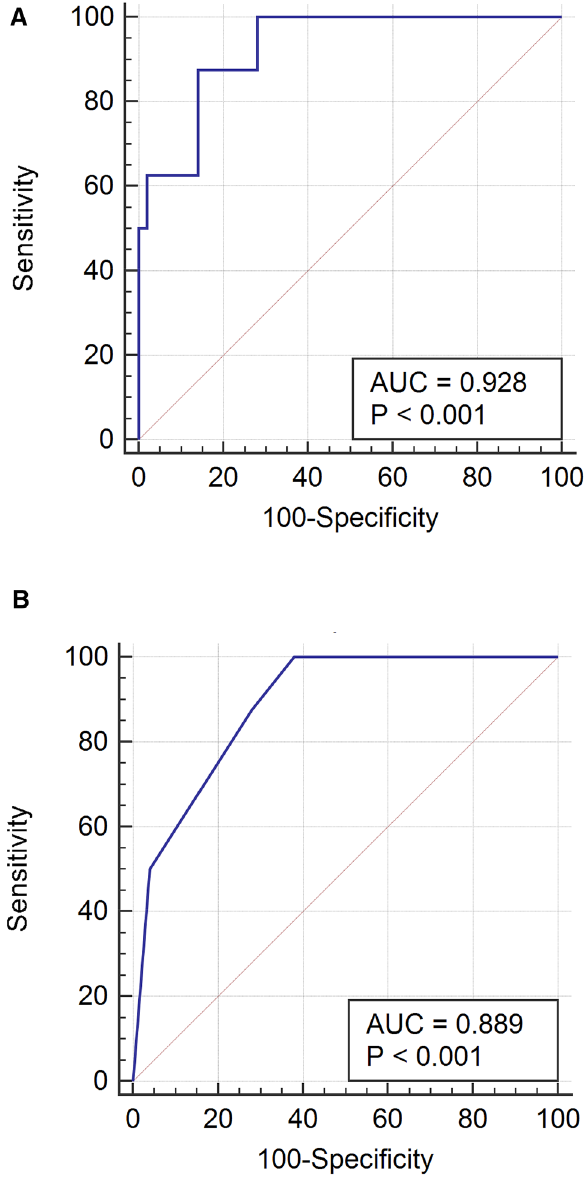
Figure 1. Summary of univariate odds ratios and multivariable logistic regression model. ( A ) AUC for full model 0.928 (95% CI 0.828–0.979, p < 0.0001). ( B ) Simplified model includes the following categorical variables as risk factors for intubation: neutrophil count > 4 × 10 9 L and respiratory rate > 18. AUROC for this model is 0.889 (95% CI 0.779–0.956, p = 0.0002). AUROC: Area under receiver operating